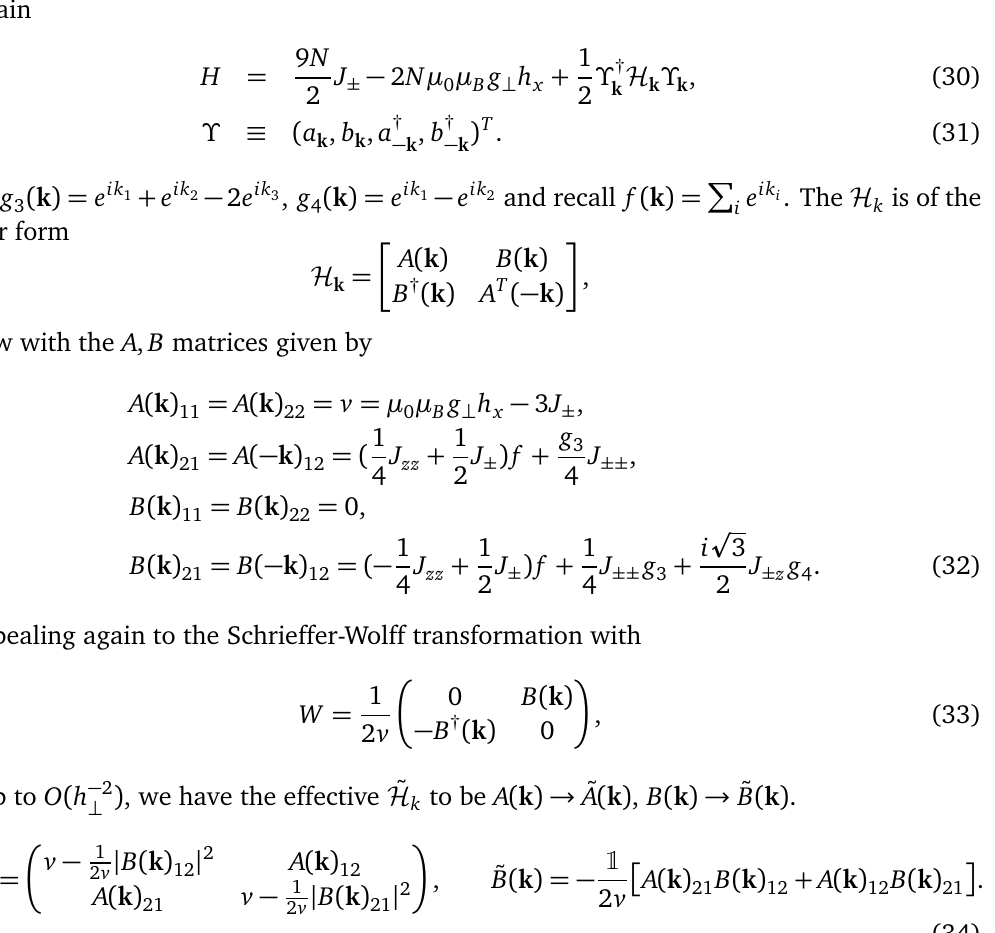
Figure 5: Edge state in a cylindrical geometry. The y -direction is periodic, while x -direction contains 50 sites. The parameters are J u =